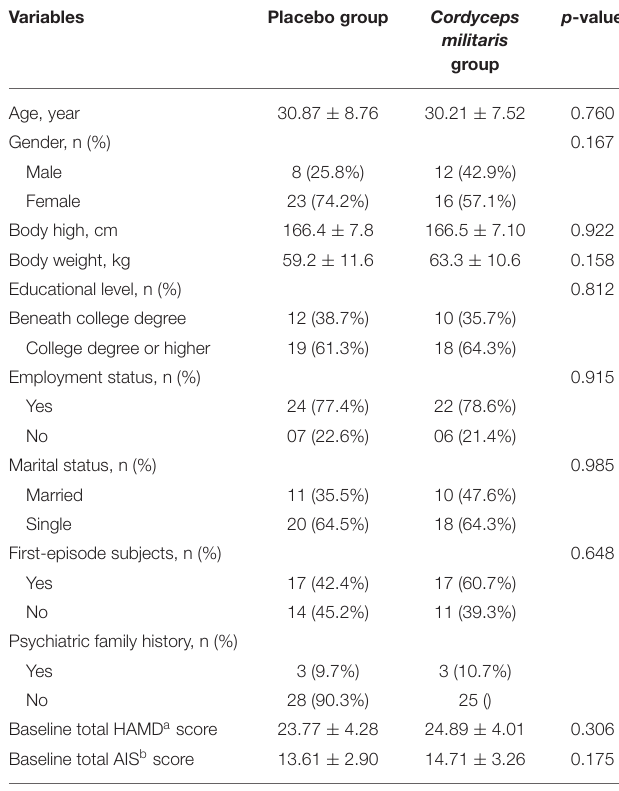
TABLE 1 | Sociodemographic data and clinical characteristics of the